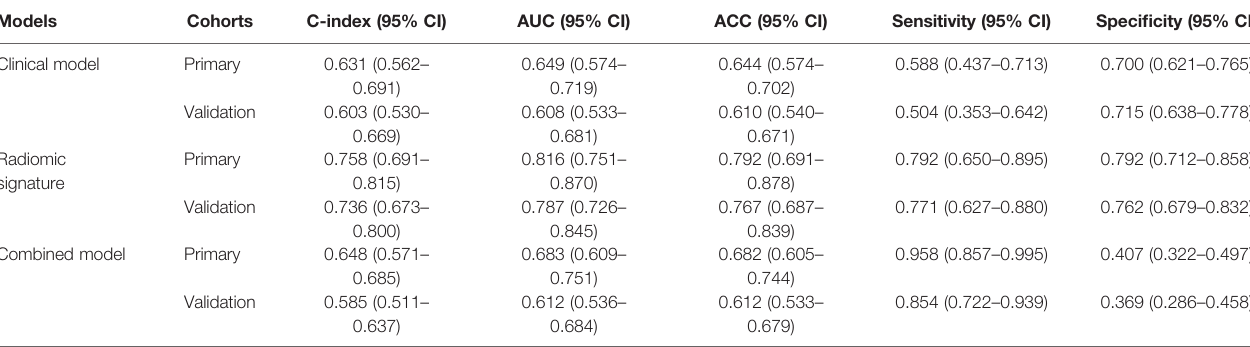
TABLE 3 | Model performance on predicting DFS and 3-year DFS probability.